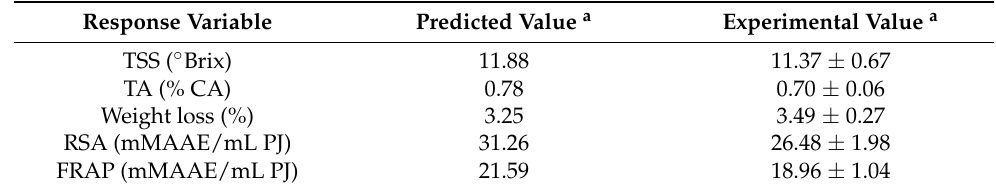
Table 5. The predicted and experimental values of responses of “Wonderful” pomegranate coated with optimum formulation of gum arabic, maize starch, lemongrass oil, and